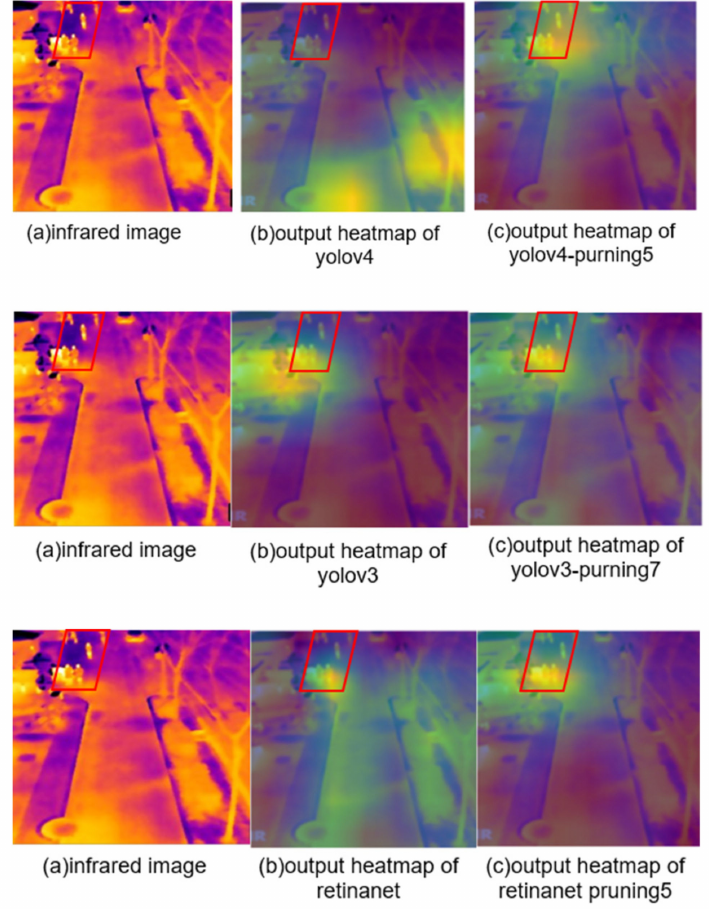
Figure 7. Presentation of feature visualization results. Figure ( a ) is the original input image. Figure ( b ) shows the results of the network feature visualization before pruning. Figure ( c ) shows the results of the network feature visualization after pruning.